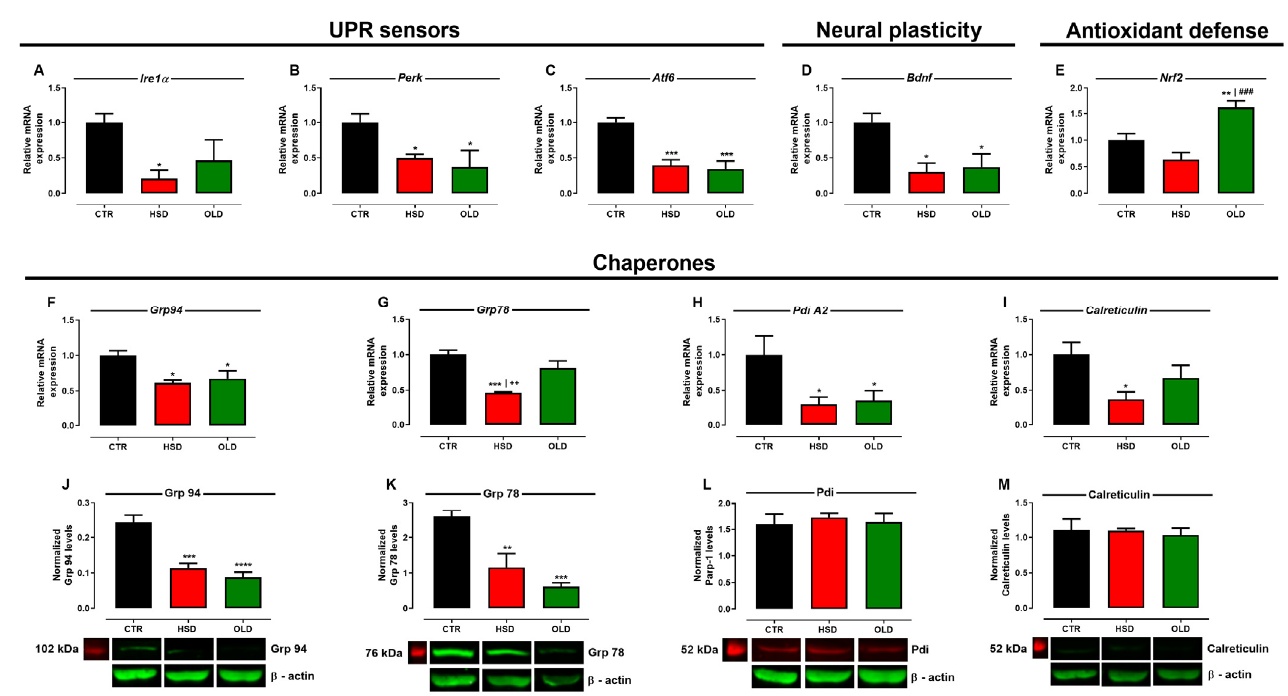
Figure 5. Expression of UPR pro-adaptive markers in hippocampus. Relative mRNA expression of UPR sensors Ire1 α ( A ), Perk ( B ), and Atf6 ( C ), neural plasticity Bdnf ( D ), antioxidant defense Nrf2 ( E ), and chaperones Grp94 ( F ), Grp78 ( G ), PdiA2 ( H ), and Calreticulin ( I ); and protein levels of chaperones Grp94 ( J ), Grp78 ( K ), Pdi ( L ), and Calreticulin ( M ) assessed in the hippocampi of rats fed a standard chow (CTR, n = 5) and a high-sucrose diet (HSD, n = 5) until 6 months from weaning and middle-aged (20-months-old) animals fed a standard chow (OLD, n = 5). Gene expressions were normalized to the relative levels of GAPDH, the results are expressed as the fold change values of 2 −ΔΔ CT , and protein levels are expressed as relative density normalized by anti- β -Actin. Bars represent the mean ± SEM (one-way ANOVA Newman–Keuls). * p < 0.05, ** p < 0.01, *** p < 0.001, **** p < 0.0001 when compared to CTR, ++ p < 0.01 when compared to OLD, and ### p < 0.001 when compared to HSD.